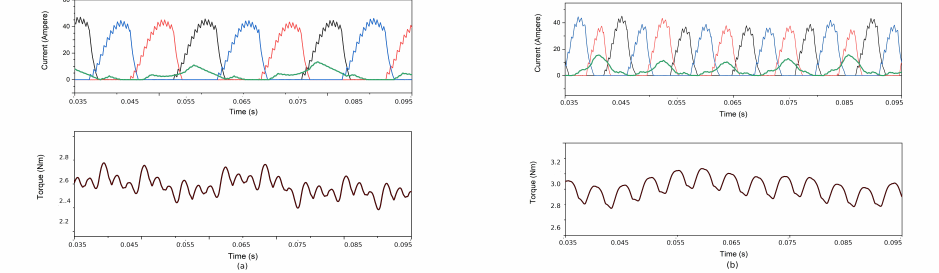
Figure 14. Proposed HESRM dynamic performance of variable speed: ( a ) 1000 rpm and ( b ) 2500